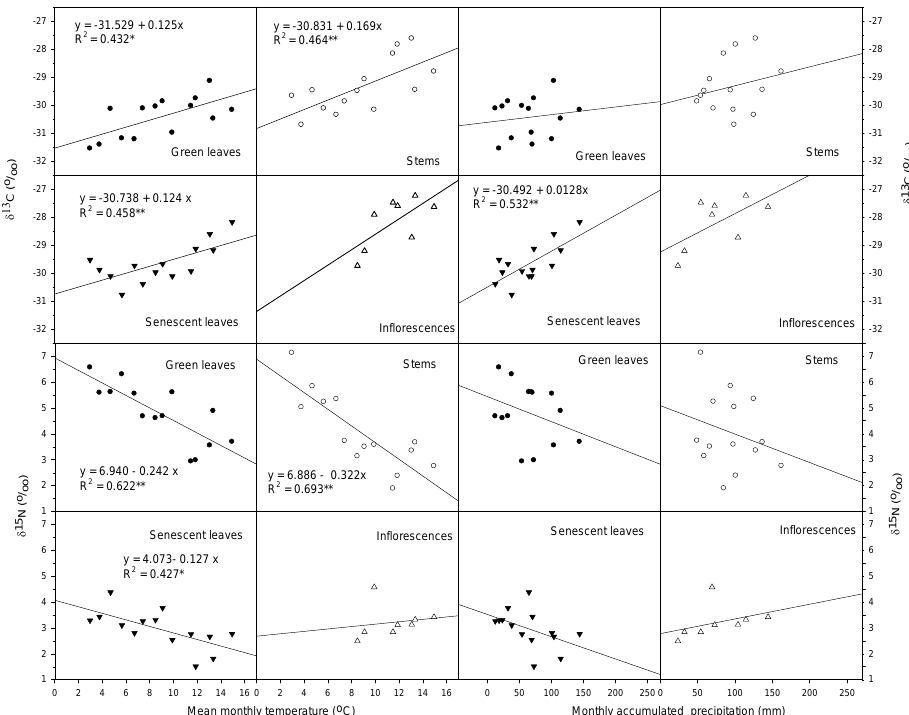
Fig. 8. Regression analysis of foliar natural abundance of stable isotopes in different ryegrass tissues ( δ 13 C and δ 15 N) in relation to climatic conditions (mean monthly temperature and accumulated monthly precipitation over a 30 d period prior to sampling). The regression equation is shown only in cases where a significant correlation was observed.